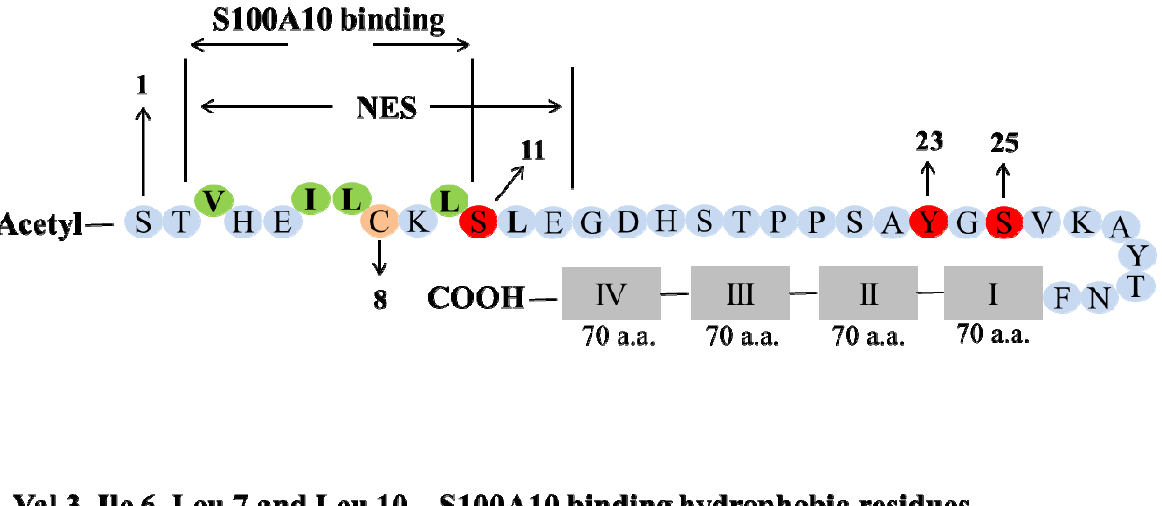
Figure 1. Domain structure of annexin A2. Annexin A2 is composed to two domains—the amino-terminal domain and carboxyl-terminal domain. The amino-terminal is the site for post-translational modifications (Ser-1–Phe-32) such as (Ser-1) and phosphorylation (Ser-11, Tyr-23, Ser-25). Additionally it also encompasses the redox reactive cysteine residue (Cys-8) and the nuclear export sequence (NES) (Val-3-Leu-12). The S100A10 binding site is an amphipathic α -helix, with the hydrophobic residues, Val-3, Ile-6, Leu-7 and Leu-10 making contacts with S100A10. The carboxyl-terminal core domain includes four predominantly alpha-helical domains each containing 70 amino acids. This carboxyl-terminal core domain contains binding sites for heparin and RNA, calcium and phospholipid and as well as for